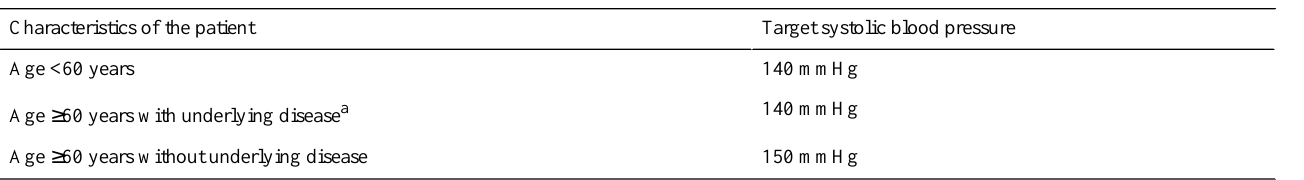
Table 3. Target systolic blood pressure